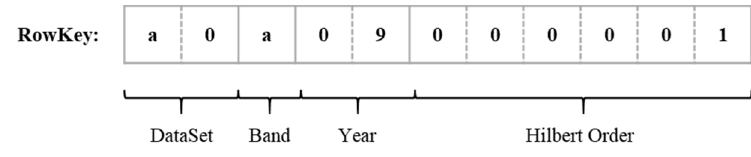
Figure 3. Remote sensing data system with the HDFS and HBase.